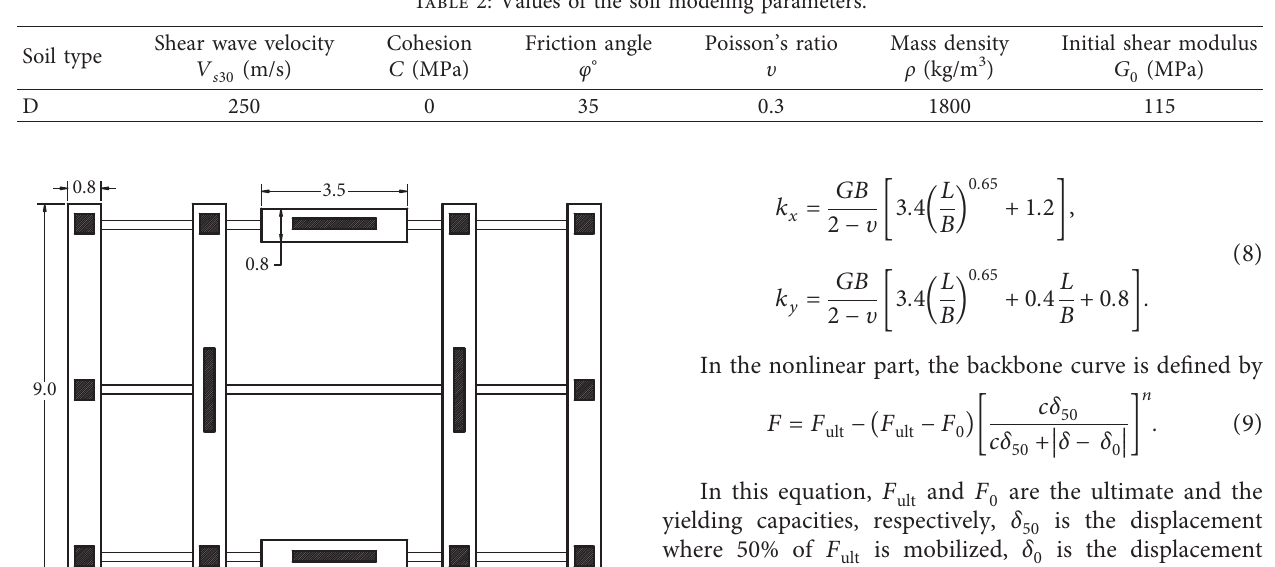
Figure 3: Plan of